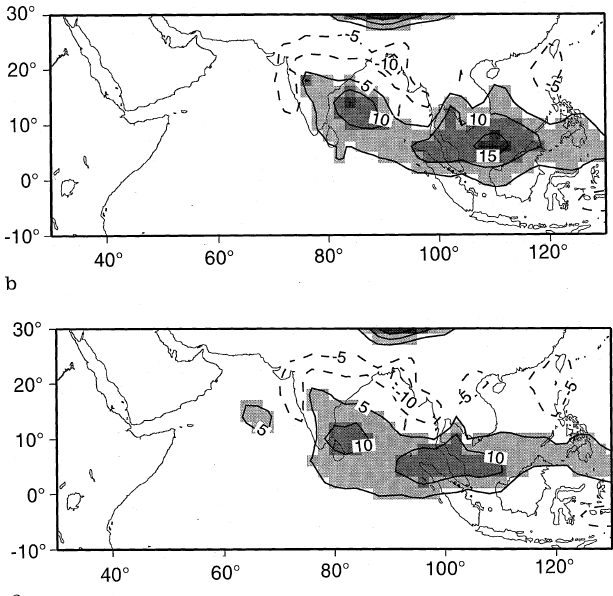
Fig. 5a, b. Precipitation error for July in mm day (cid:255) 1 between a the reference REF31 and the climatology and b the experiment GWD31 and the climatology; values over 5mm day (cid:255) 1 are